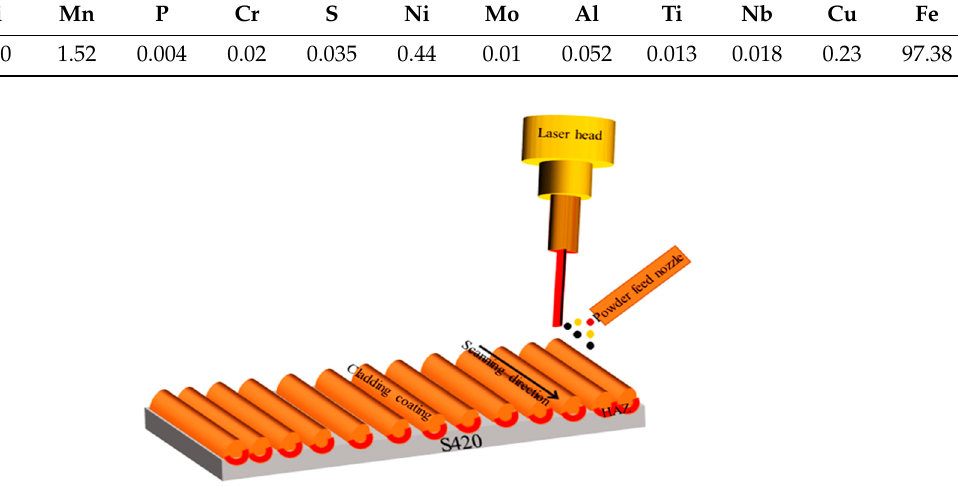
Figure 1. Schematic of laser cladding process.